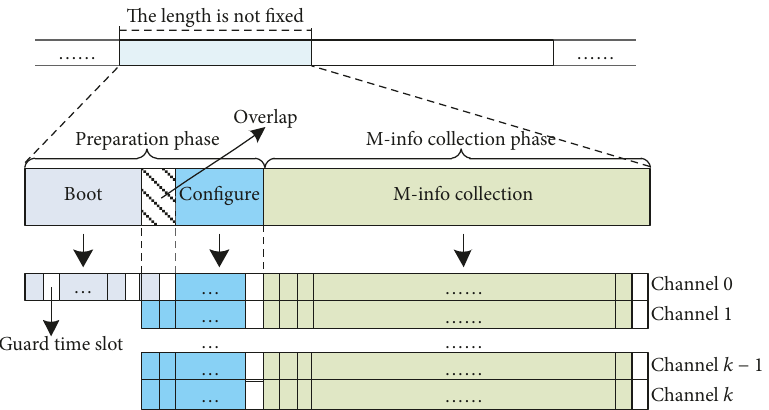
Figure 4: The frame structure employed by the MCP-SD-ATN.